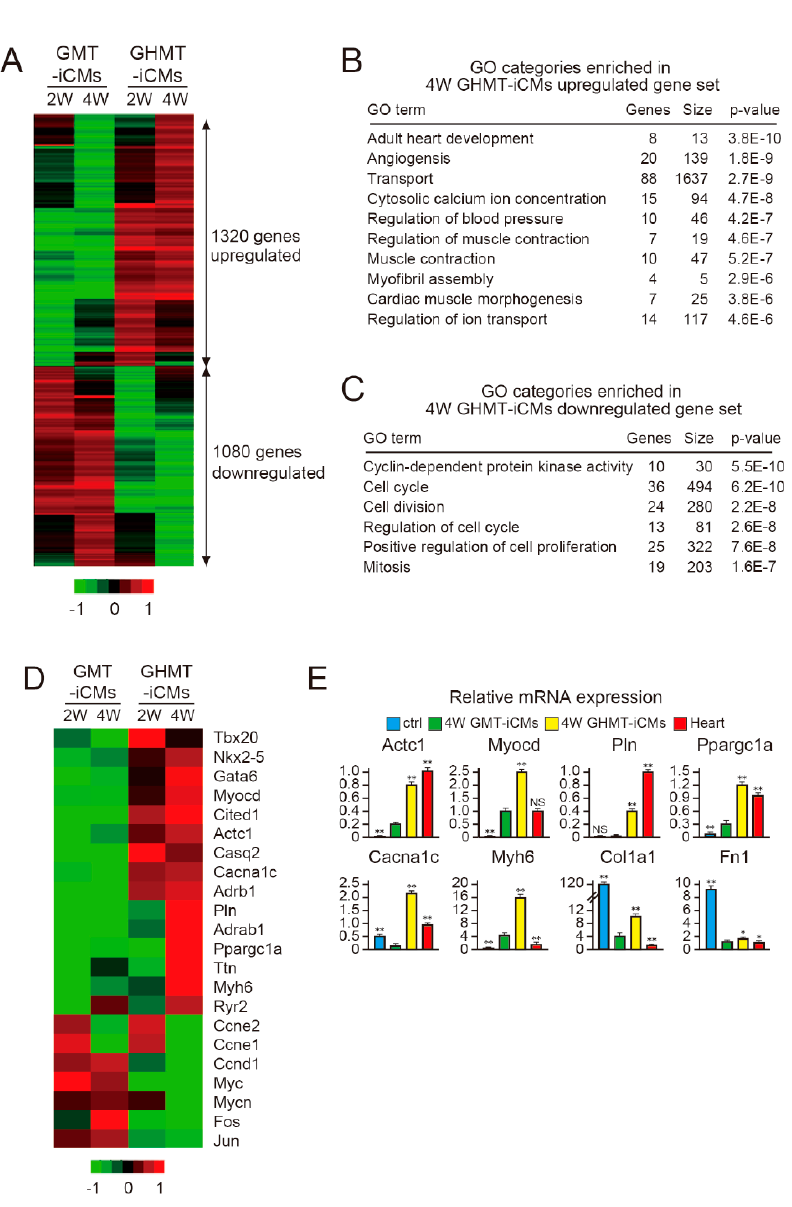
Figure 5. Hand2 represses cell cycle-promoting genes during cardiac reprogramming. ( A ) Microarray analyses of FACS-sorted α myosin heavy chain ( α MHC)-GFP + cells induced with pMX-GMT or pMX-GHMT after two (2W) and four weeks (4W). Red indicates increased gene expression, whereas green indicates decreased gene expression; ( B ) gene ontology (GO) term analyses for the upregulated genes in GHMT–iCMs (cardiomyocyte-like cells) compared to expression in GMT-iCMs after four weeks. Cardiac-related GO categories are shown; ( C ) GO term analyses for the downregulated genes in GHMT-iCMs compared to expression in GMT-iCMs after four weeks. Cell cycle-related GO categories are shown; ( D ) heatmap images of the gene expression patterns of cardiac- and cell cycle-related genes; ( E ) the relative mRNA expression of the indicated genes was determined by qRT-PCR ( n = 3 independent triplicate experiments). All data are presented as mean ± SD. * p < 0.05, ** p < 0.01 vs. the relevant control. The scales are − 1 to 1 in log2.